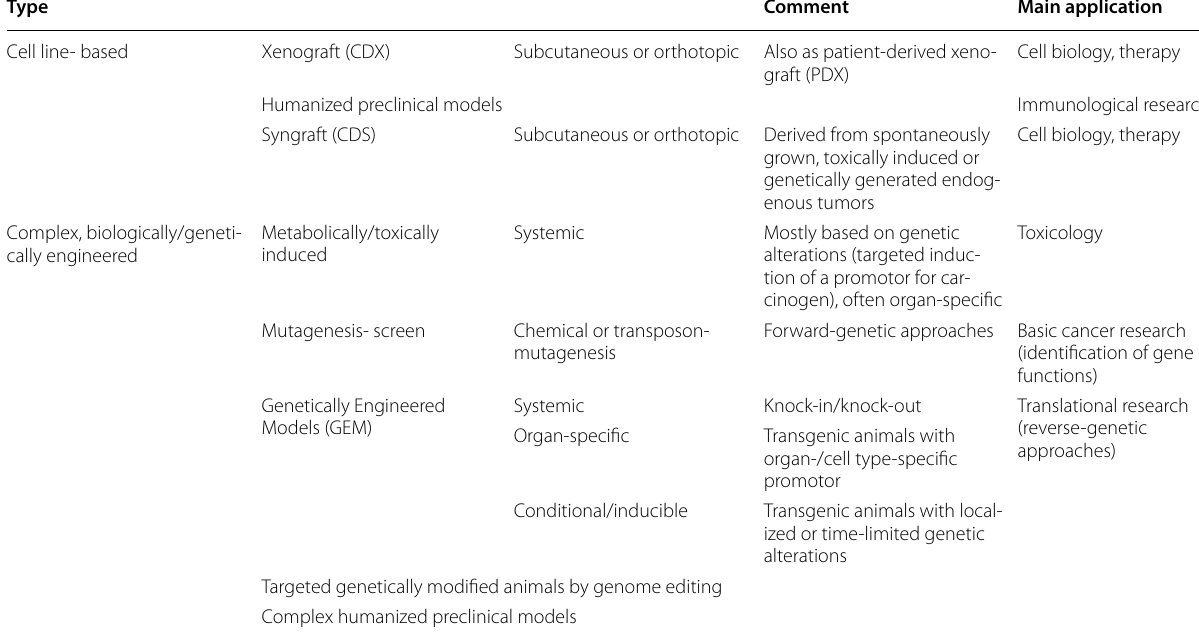
Table 1 Simplified overview of frequently used systems of animal models in translational cancer research